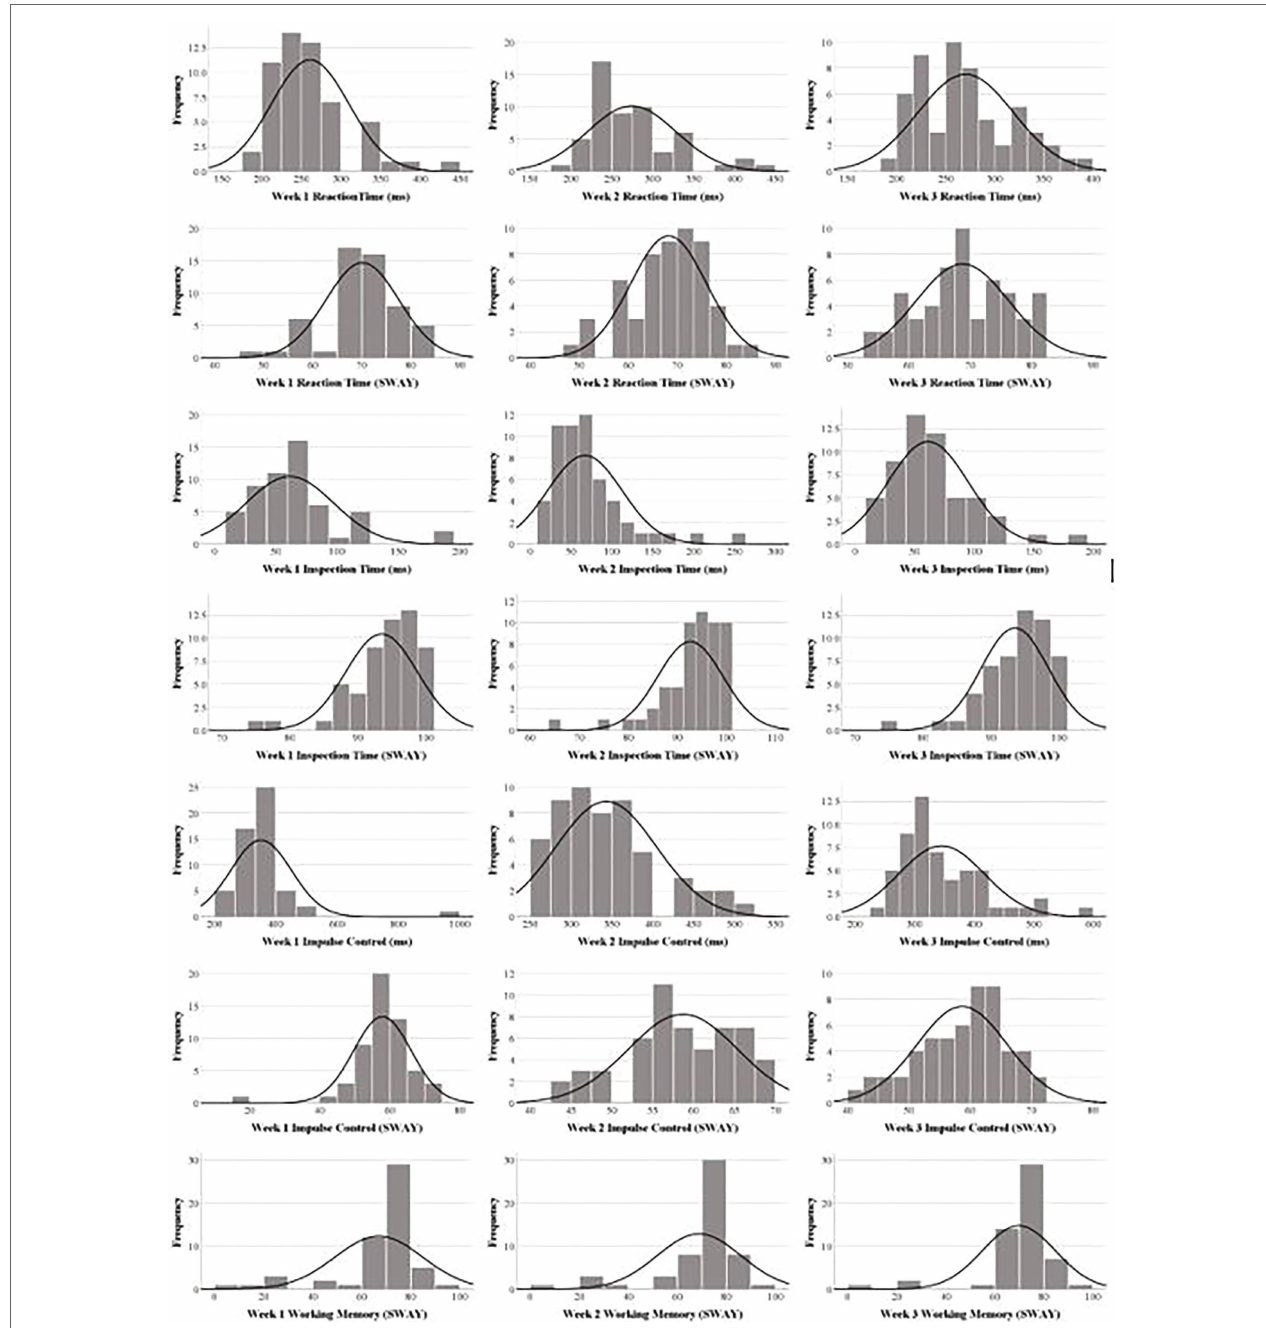
FIGURE 2 | Histograms for the four SWAY